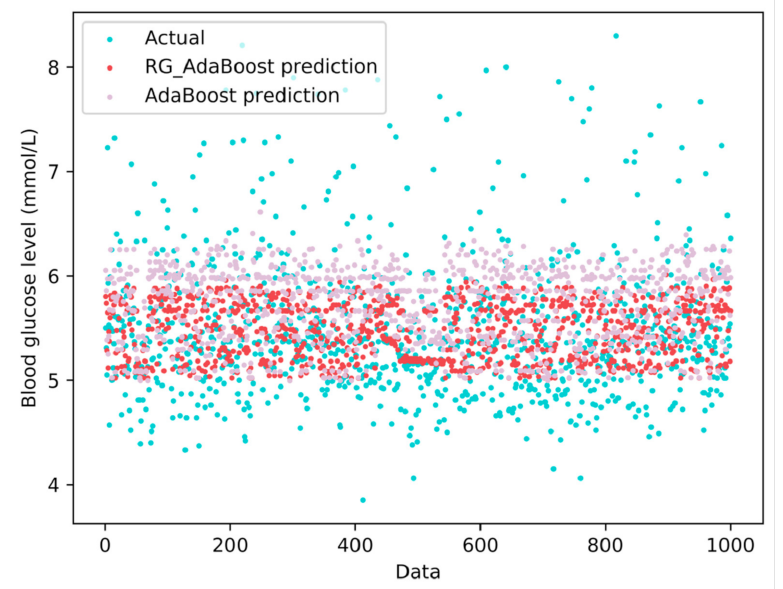
Figure 9. The scatter plot diagram of the actual and predicted blood glucose (fasting/pre-prandial) levels by the RG_AdaBoost and AdaBoost